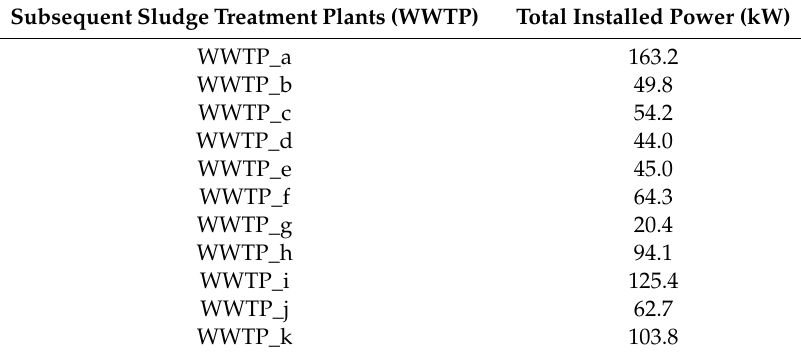
Table 3. Total installed power for ATAD in the analyzed sewage treatment plants.